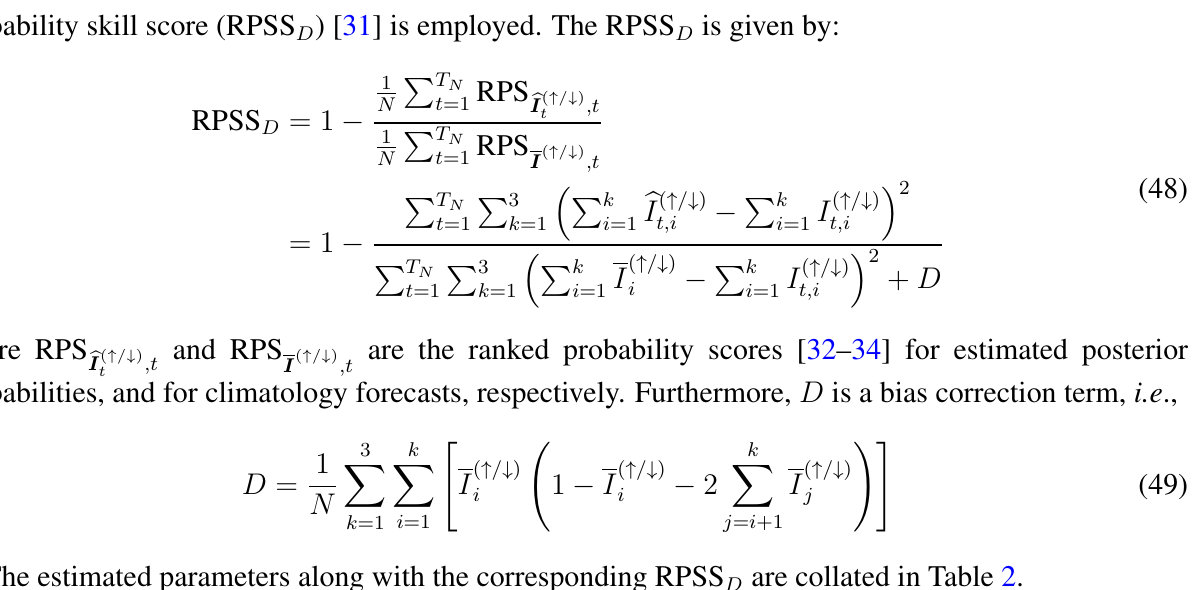
Table 2. Estimated parameters and RPSS